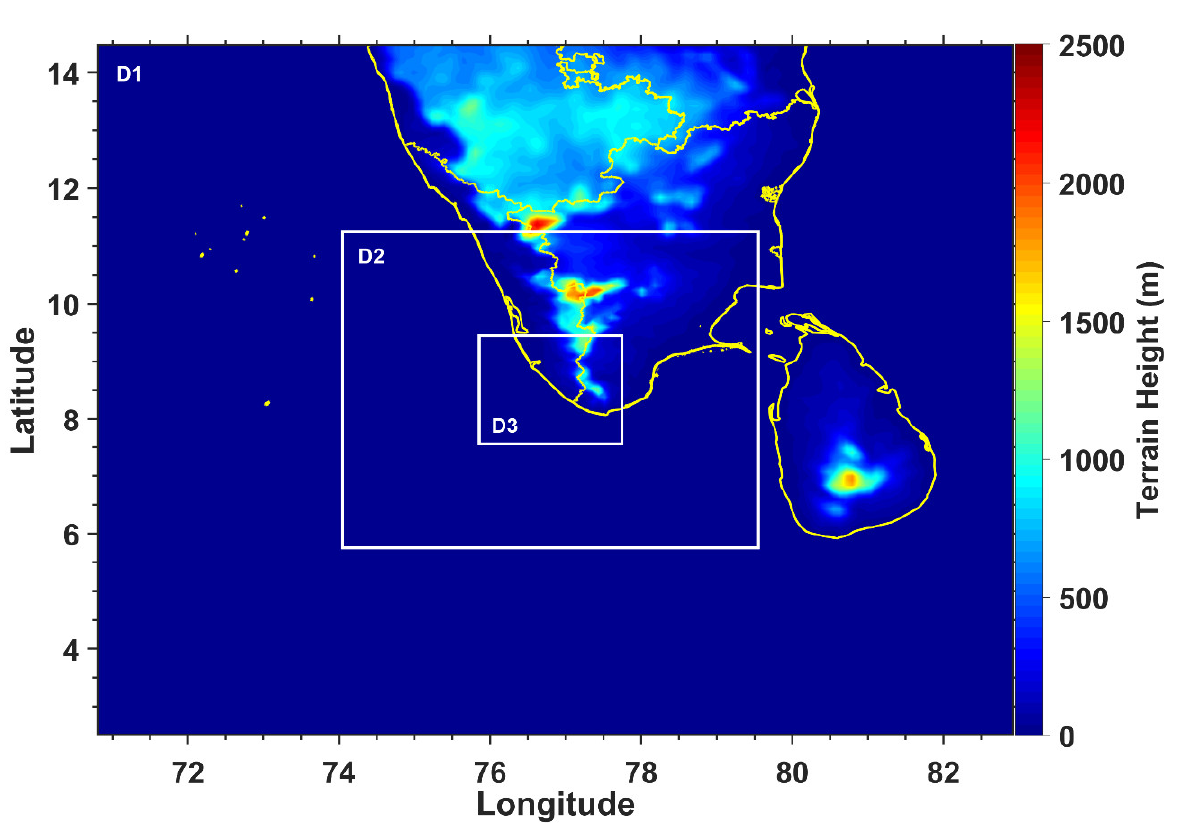
Figure 4. For better simulation of the thunderstorm event, the innermost domain (D3) with 1 km resolution has been considered, as suggested by Rajeevan et al. [22]. The model used 50 vertical levels. It was initialised at 00 UTC of 13 May 2018 with the NCEP global final analysis data having spatial resolution of 0.25 degree. Furthermore, the boundary condi- tions were taken from the same analysis data.